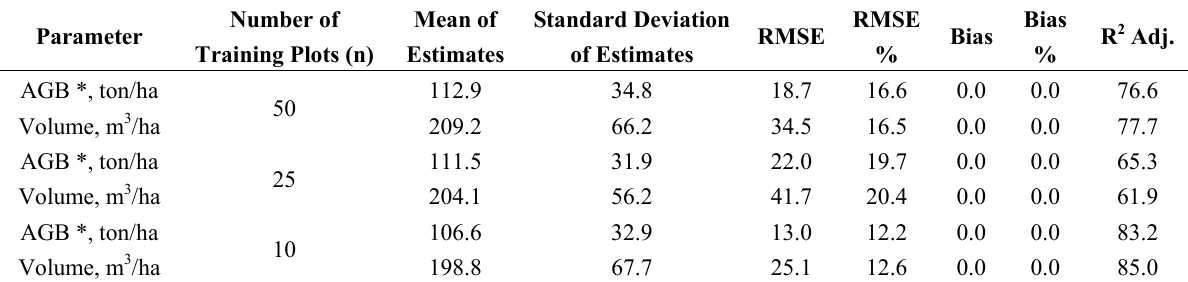
Table 5. Accuracy of the ALS prediction against field estimation.